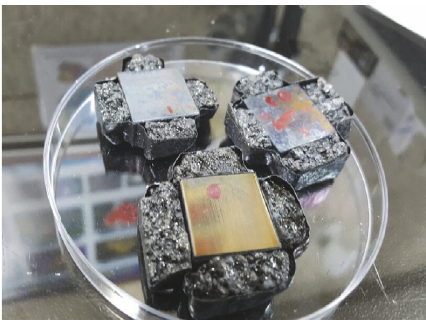
Figure 2: SEM sample